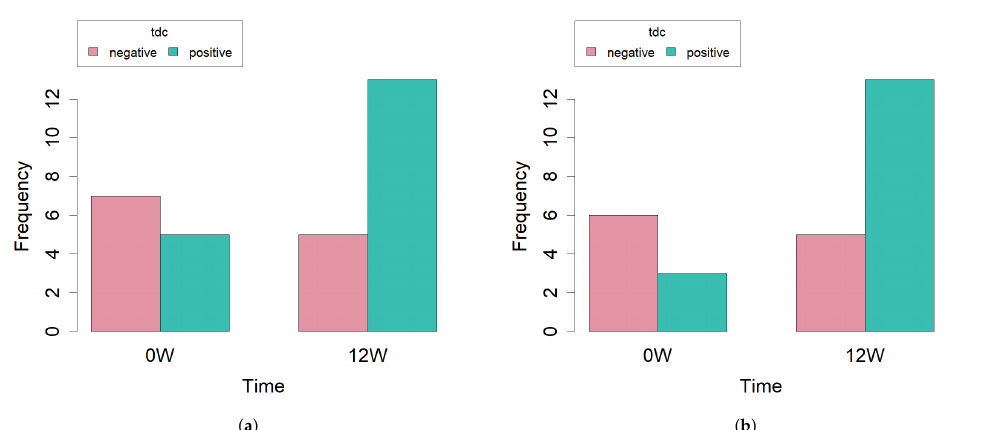
Figure 4. Bar plot of the number of strains with presence (positives) or absence (negatives) of the gene tdc , at the beginning or the end of the experiment considering strains from all diets; ( a ) Fisher’s exact test p = 0.1362) or from all but an extra virgin olive oil enriched diet; ( b ) Fisher’s exact test p = 0.0968 ) .